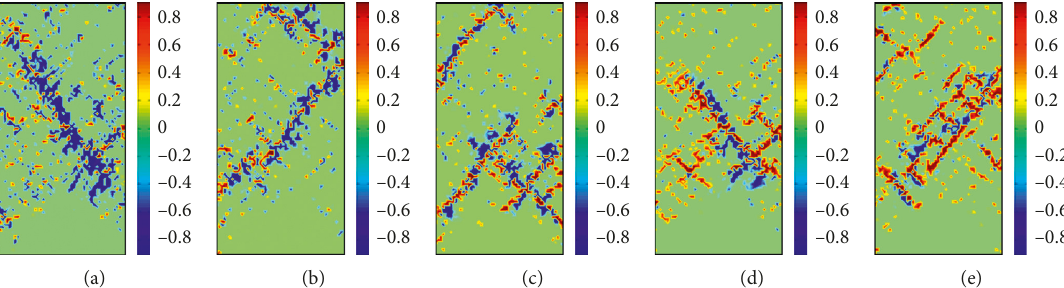
3; (b) λ 4; (c) λ 5; (d) λ 6; (cid:30) (cid:30) (cid:30) (cid:30)